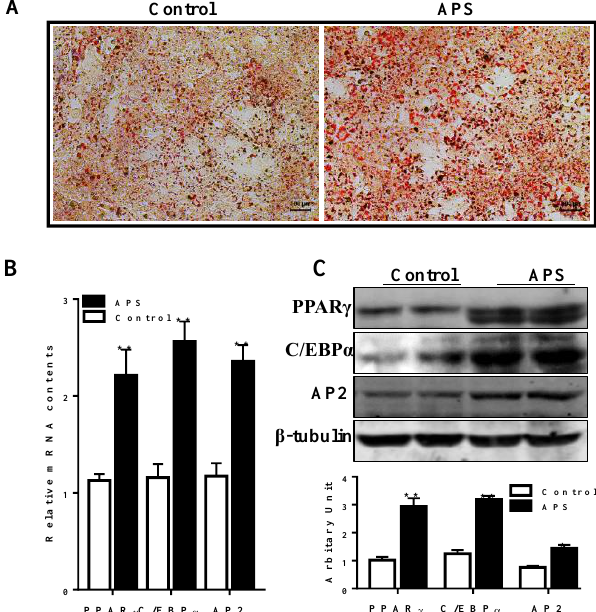
Figure 2. APS enhanced adipogenesis in 3T3-L1 pre-adipocytes. ( A ) Oil-red-O staining showed that more lipids were accumulated in the APS treated cells. ( B ) mRNA expression of adipogenic transcriptional factors, including proliferator-activated receptor γ (PPAR γ ), CCAAT/enhancer binding protein α (C/EBP α ), and fatty acid binding protein (aP2). ( C ) Protein contents of PPAR γ , C/EBP α , and aP2. n = 6, * p < 0.05, ** p <